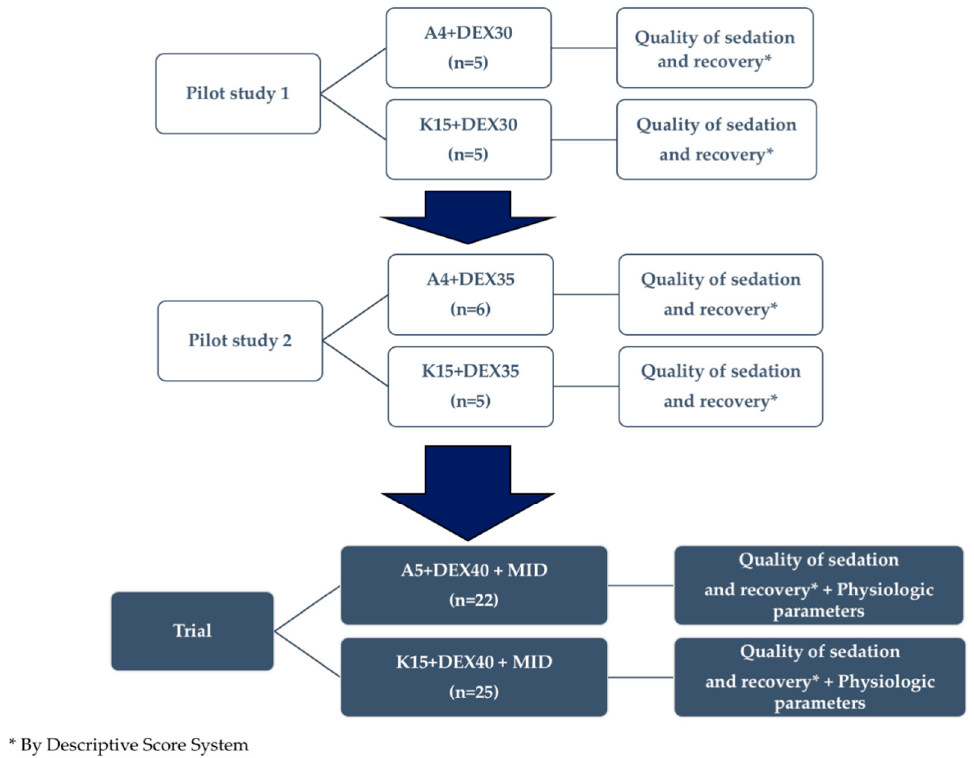
Figure 2. Experimental protocol that includes the two pilot studies. A4 = alfaxalone 4 mg / kg; DEX30 = dexmedetomidine 30 µ g / kg; DEX35 = dexmedetomidine 35 µ g / kg; K15 = ketamine 15 mg / kg; A5 = alfaxalone 5 µ g / kg; DEX40 = dexmedetomidine 40 µ g / kg; MID = midazolam